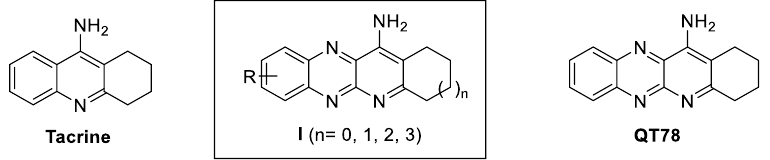
Figure 1. General structure for quinoxalinetacrines (QTs) (I), tacrine, and QT78 .